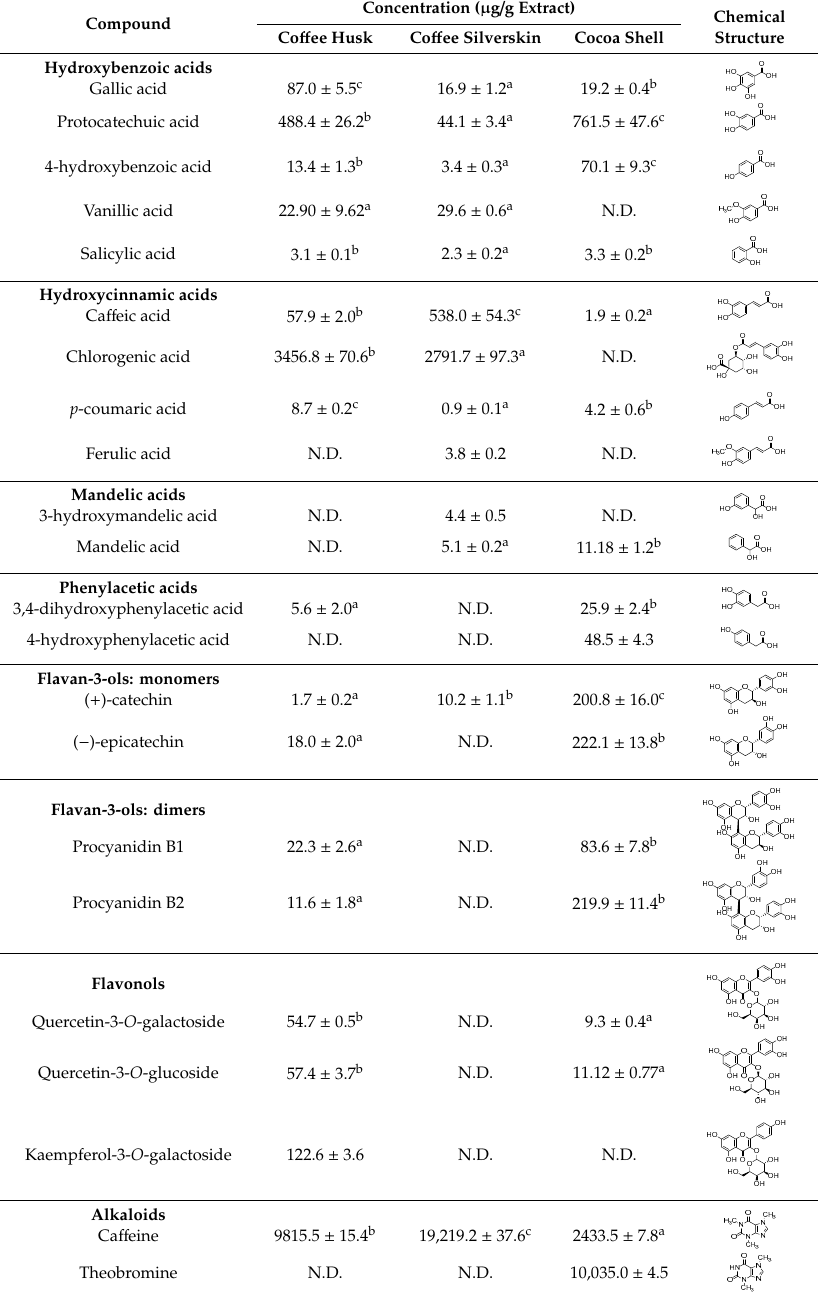
Table 1. Phytochemical composition of co ff ee husk, co ff ee silverskin, and cocoa shell aqueous extracts characterized by UPLC–ESI–MS / MS. Values are expressed as mean ± SD (n = 3). Di ff erent letters among rows indicate significant di ff erences ( p < 0.05) according to ANOVA and Tukey’s multiple range